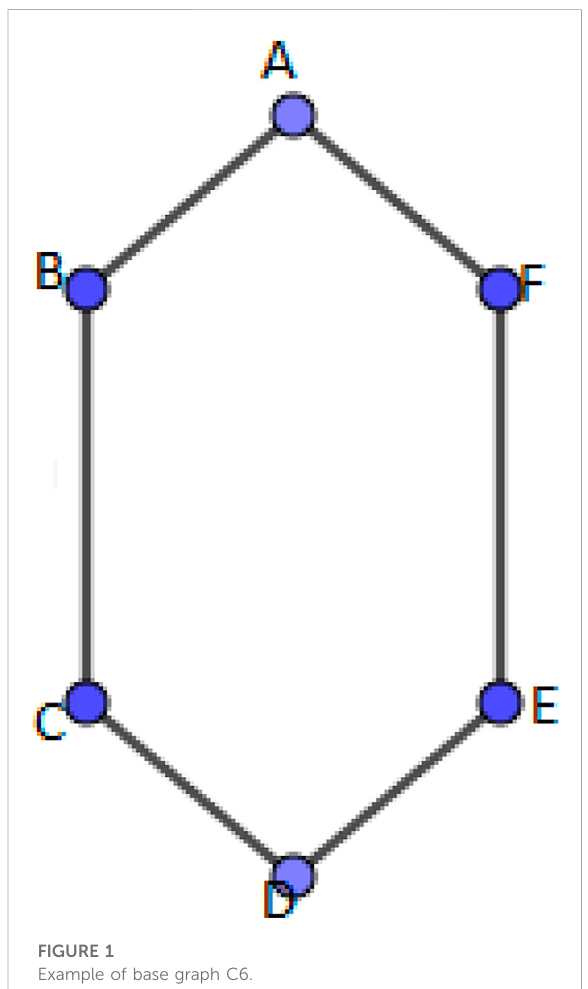
FIGURE 2 B Spl 2 ( 1 ), the 2-splitting graph of